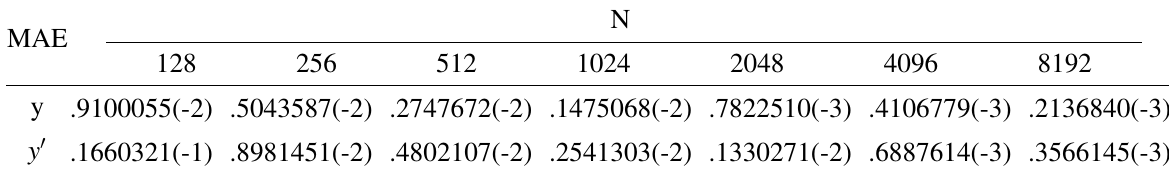
Table 2 Maximum absolute error in y ( x ) = ( 1 + x ) − 2 and y (cid:48) ( x ) for Example 5.2 .